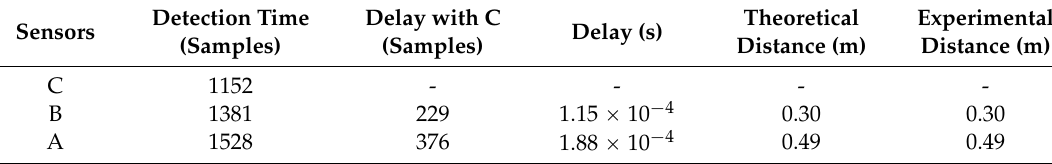
Table 1. First case study: detection time; delay with C; delay; theoretical distance; experimental distance.